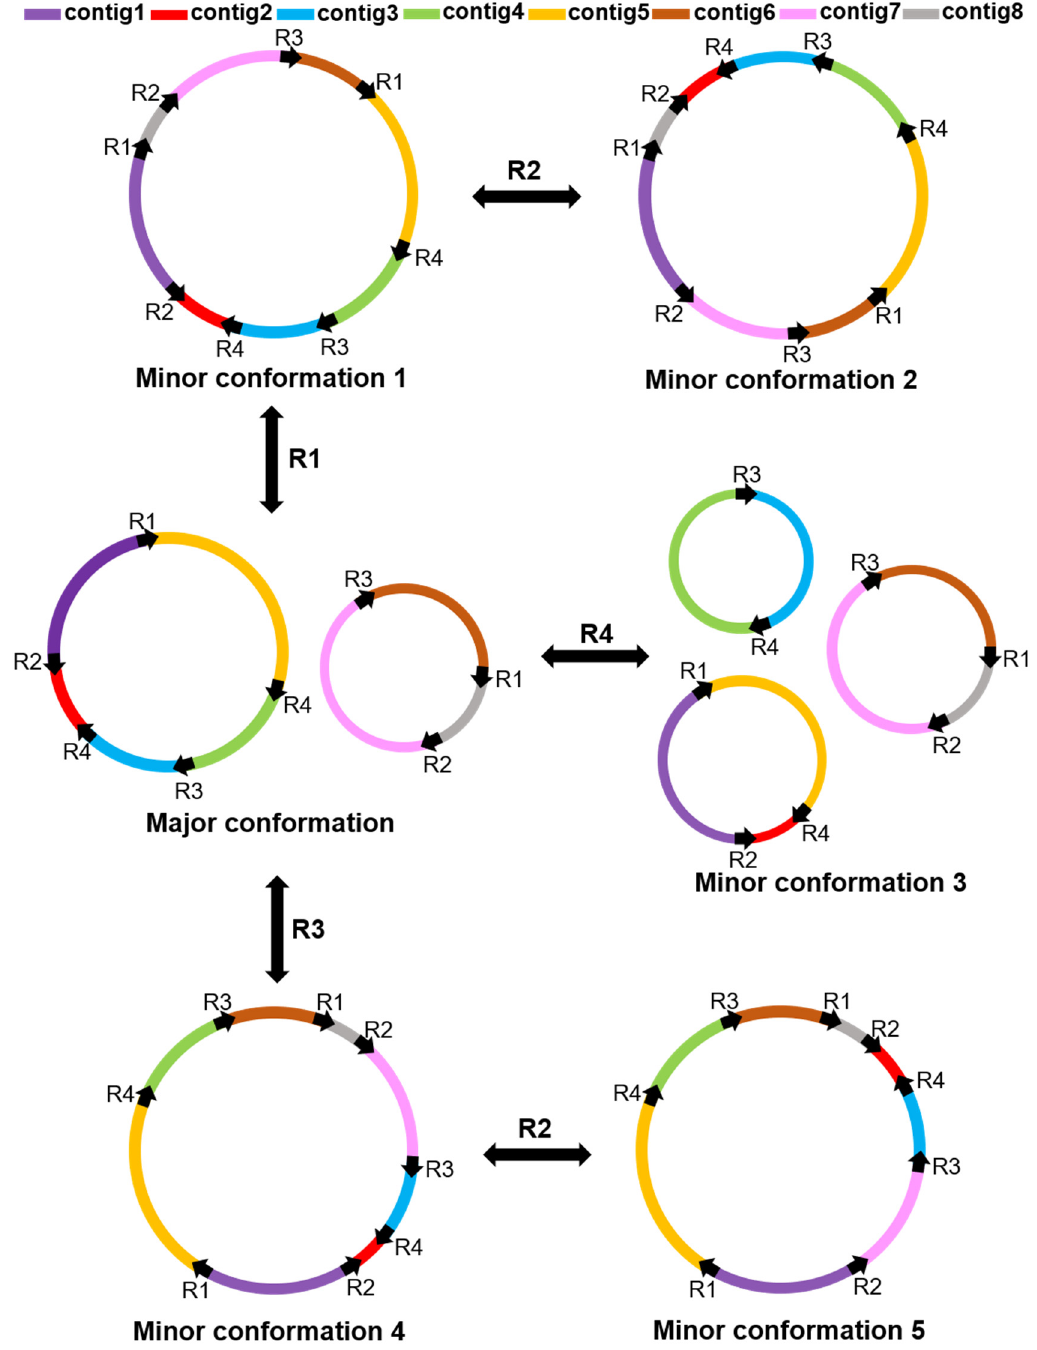
Figure 5. Hypothetical products generated by recombinations mediated by R1, R2, R3, and R4. R1, R2, R3, and R4 in the picture represent repeats 1–4. The black arrows on the circular chromosome represent the repeat sequences, and the colored lines represent the DNA fragment between the re- peats. The circles represent the mitochondrial genome conformations. Minor conformations 1, 2, 4, and 5 contain one circular chromosome, and the major conformation contains two circular chromo- somes, while minor conformation 3 contains three circular